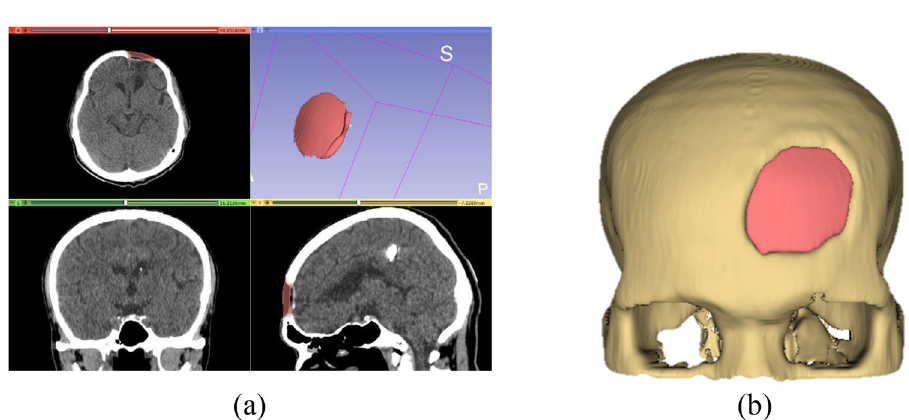
Figure 8. Baffle planner-based modelling: ( a ) model enhancement, ( b ) final implant